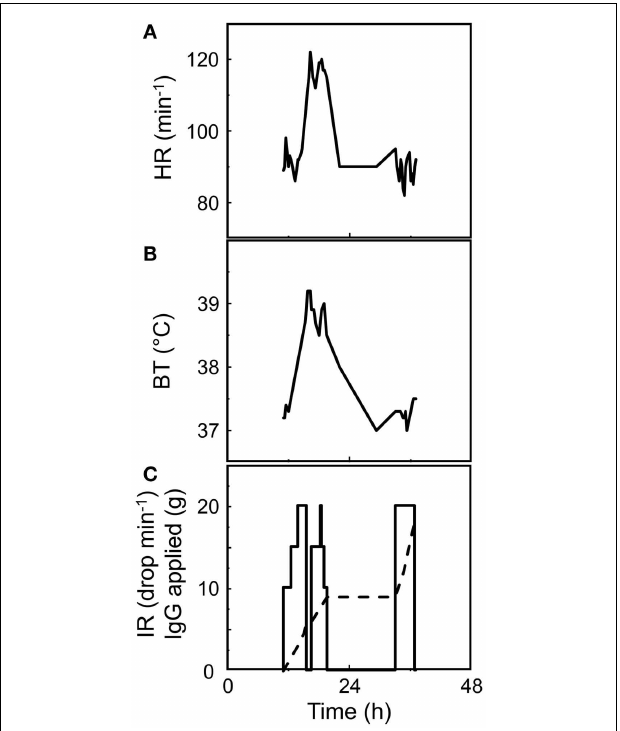
FIGURE 5 | Clinical signs of the “phlogiston” of the dark . A CVID patient received his first infusion of IVIG (a 3% solution). Despite the start of the infusion at an infusion rate [IR, (C) ] of only 10 drops per minute and incremental increase by five drops every 30min, rise of heart rate [HR, (A) ], and of body temperature [BT, (B) ] after 2h of the initiation of infusion indicated the onset of a “phlogistic” reaction and infusion was stopped. Stop of the infusion for 30min immediately let drop HR and BT. Restarting the infusion showed some negative effect and infusion was stopped after application of 9g IgG [dashed line, (C) ].The next day the rapid infusion of additional 9g of IgG was without consequence on BT and HR,